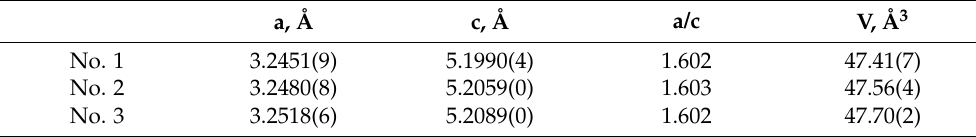
Table 1. Unit cell parameters, cell volume, and c/a ratio for different ZnO samples. a, Å c, Å a/c